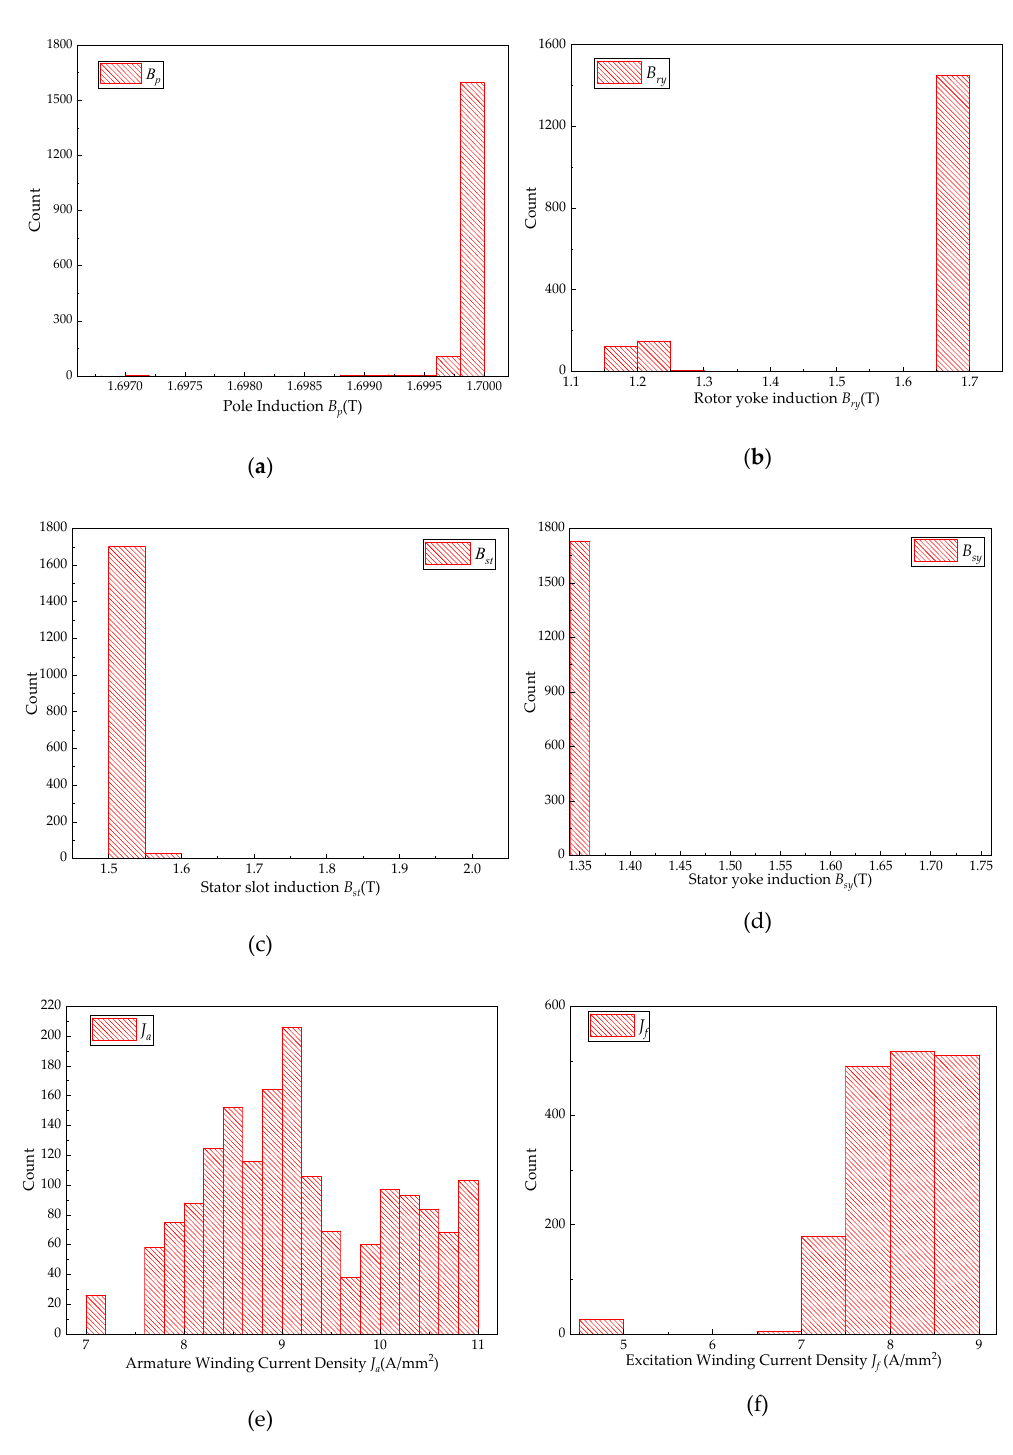
Figure 11. Data distribution of component operating points to be optimized in the preferred Pareto set: ( a ) pole induction B p ; ( b ) rotor yoke induction B ry ; ( c ) stator slot induction B st ; ( d ) slot yoke induction B sy ; ( e ) armature winding current density J a ; ( f ) excitation winding current density J f .